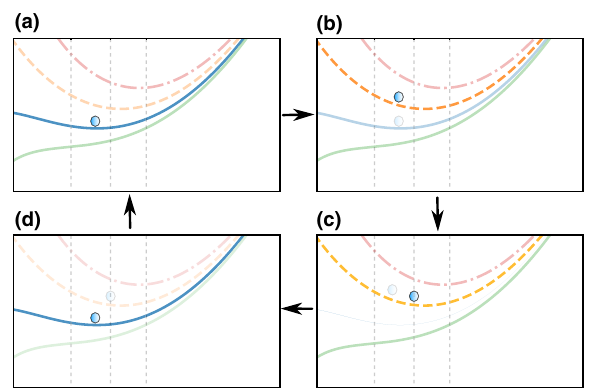
FIG. 2. An example of a qubot cycle: (a) particle b rests in its equilibrium position, while the spin states form a singlet | ψ − (cid:3) ; (b) an error occurs, changing the potential landscape seen by b ; (c) the particle is forced into loop L 2, which restores the original spin state; and (d) the particle goes back to the original equilibrium position.